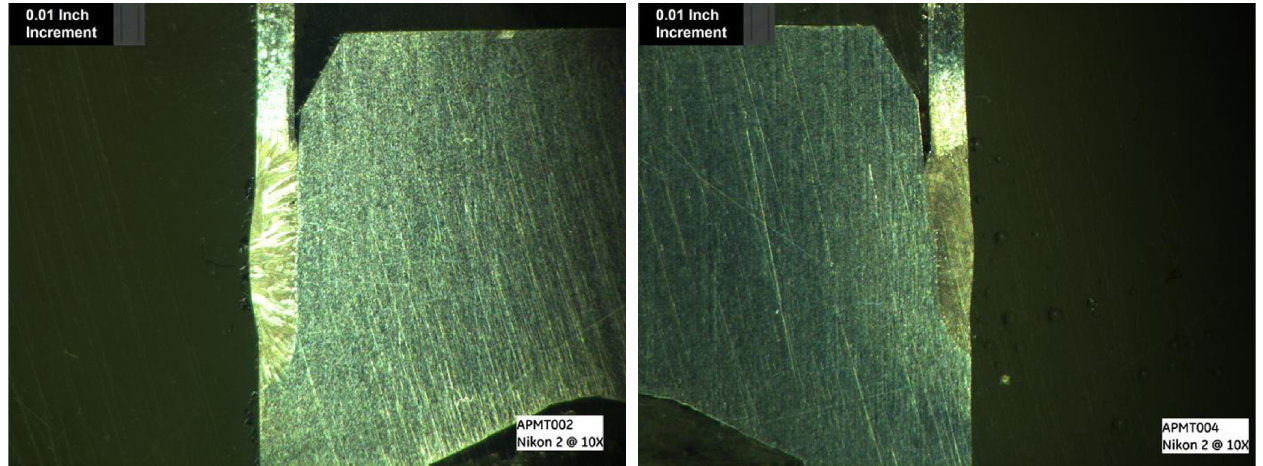
Fig. 7. Thin walled tubes of APMT welded to APMT end caps using industrial production setting.